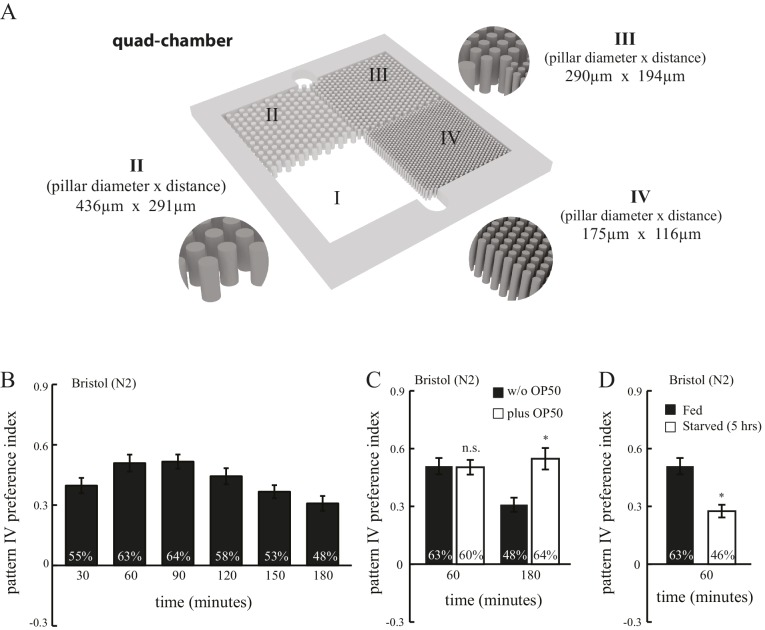
Spatial pattern selectivity is modulated by feeding state.(A) An illustration showing the dimensions of the quad-chamber. (B) The time course of spatial pattern selection. Spatial pattern preference index values and % of worms in pattern IV were measured at indicated time points, n = 10. (C) The presence of food (E. coli OP50) in the chamber prolonged the selection of pattern IV. n = 10. (D) Starvation (5 hr prior to loading) diminished pattern selectivity of N2 worms. n = 10 for fed worms, and n = 4 for starved worms. *p<0.05; n.s. not significant; Student’s t test. Error bars denote s.e.m.